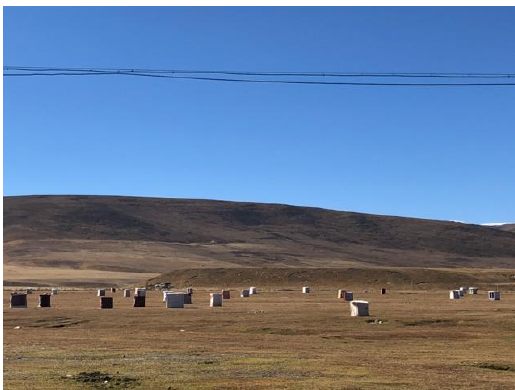
Figure 4. Meditation huts scattered around the field just outside the main quarters.